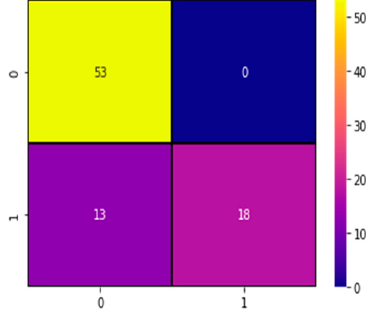
Figure 10. Confusion matrix of the Modified XGBoost.